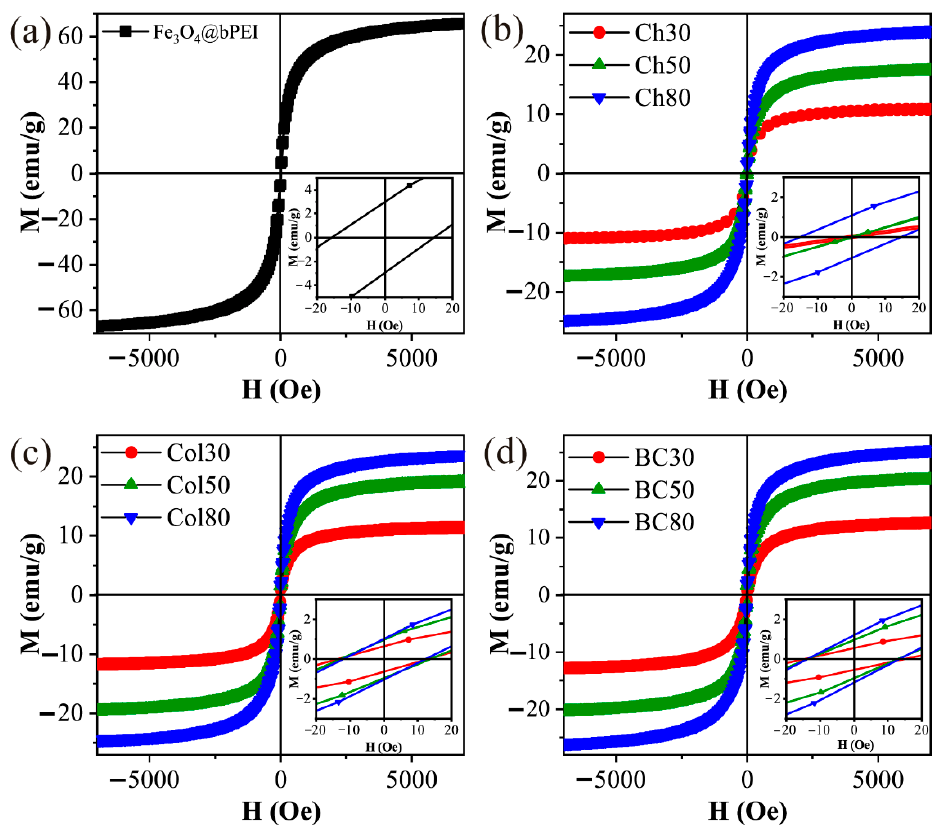
Figure 7. Magnetization curves of: ( a ) SPIONs; ( b ) Ch-based films; ( c ) Col-based films; and ( d ) BC-based films.